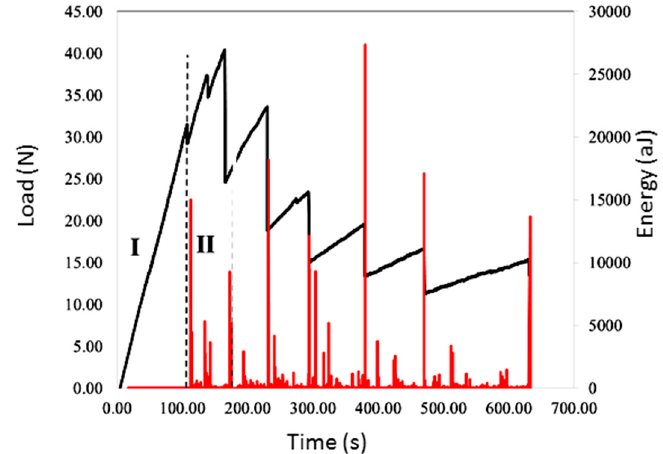
Figure 5. Load–time and AE energy–time curves for the reference laminate.